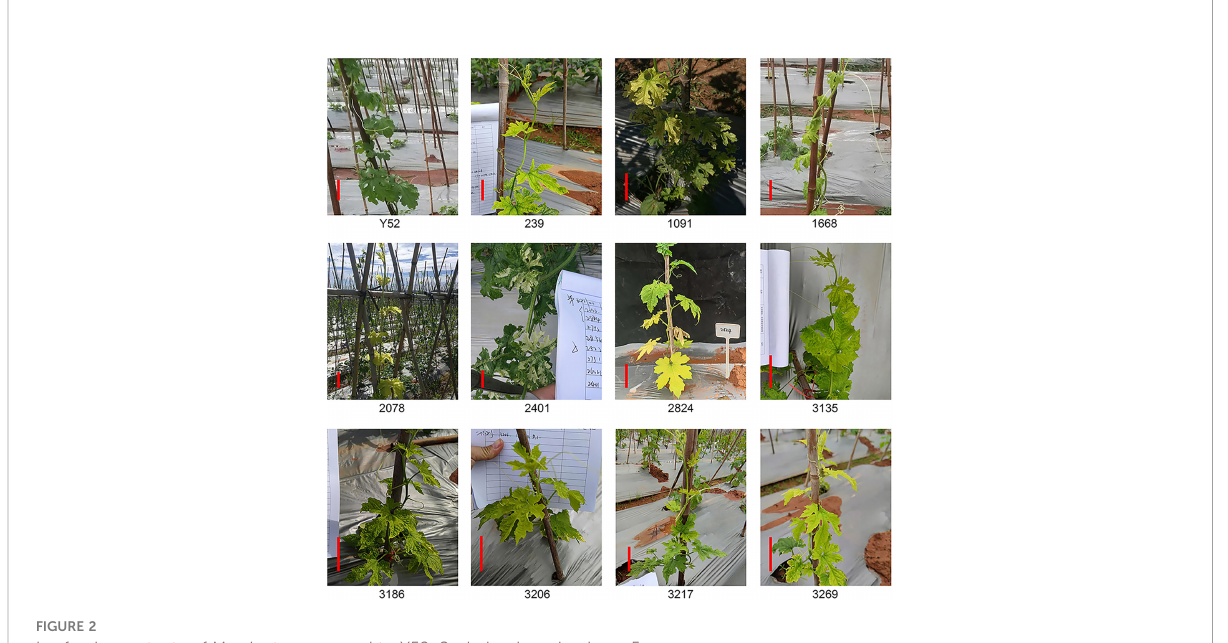
FIGURE 2 Leaf color mutants of M 2 plants compared to Y52. Scale bar in red color = 5 cm.